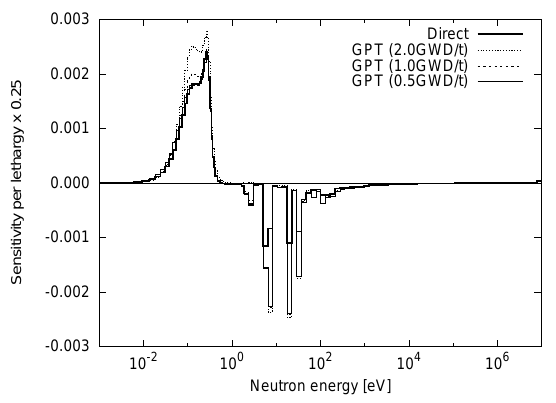
Figure 5. Sensitivities of Pu-239 number density to Gd-155 (n, γ ) cross section